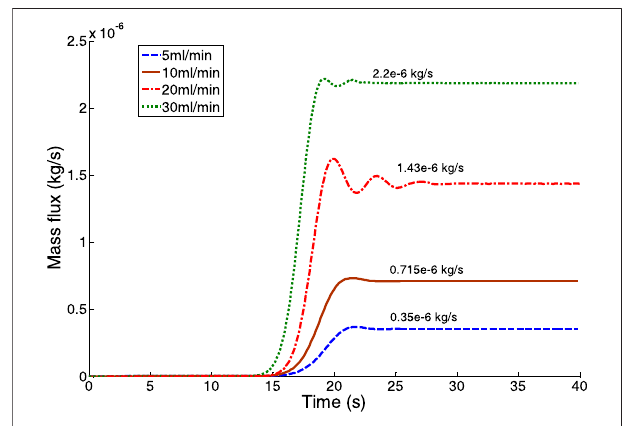
FIGURE 3 | Evolution of gas mass fl ux on the top boundary over